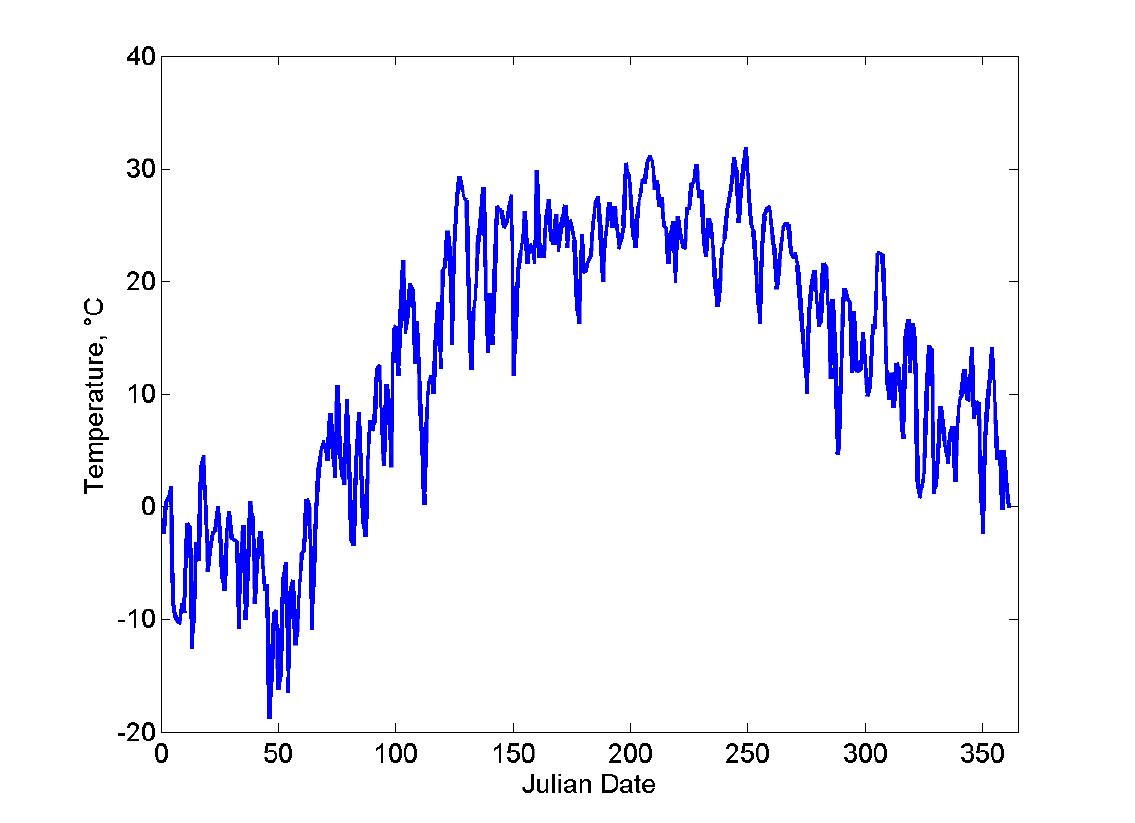
Figure 3. Daily temperature highs for London, Ontario, Canada, for the 2015 calendar year, measured at weather station London CS. Data provided by Environment